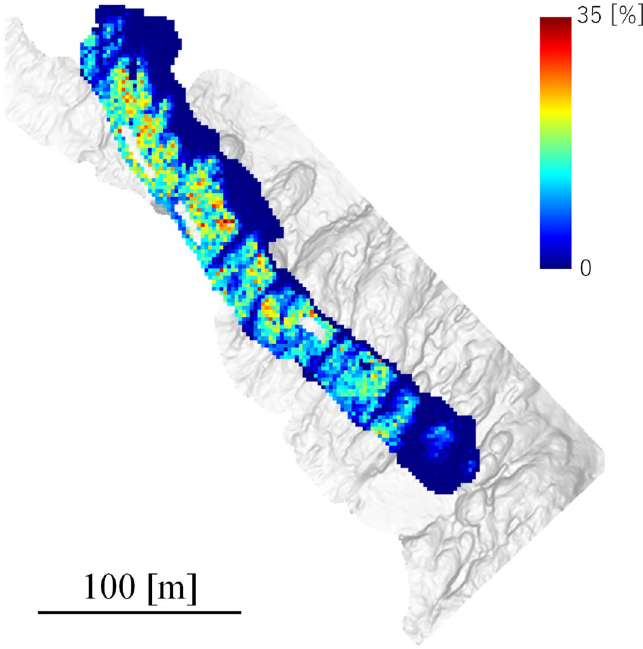
Figure 8. Distribution map of coral cover prediction. The color gradation shows the percent coral